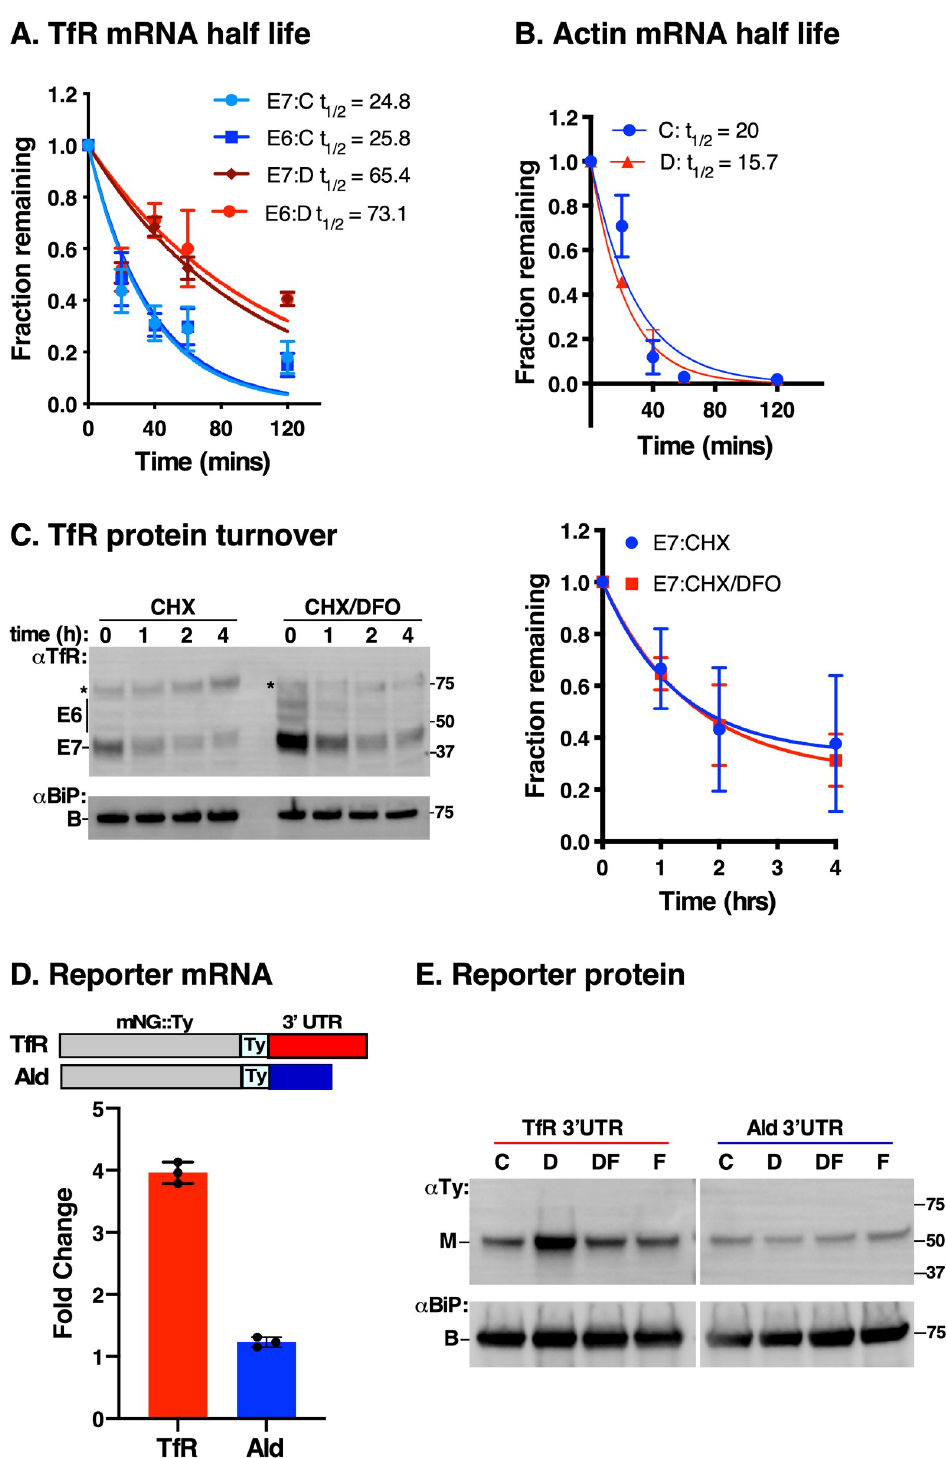
Fig 2. TfR turnover kinetics following iron starvation. A . Log phase cells (~5x10 5 cells/ml) were pre-treated with DFO (D) or untreated (C) for 5 hr and then incubated with sinefungin (5 μ g/ml, 5 min) to block trans-splicing and actinomycin D (10 μ g/ml) to inhibit transcription. Total RNA was isolated at specified time intervals and relative mRNA levels of E6 & E7 were determined by qRT-PCR normalised to 28S ribosomal RNA as internal control. Values plotted on graphs are normalised to that of time zero. The estimated half-life (t 1/2 , min) was calculated based on